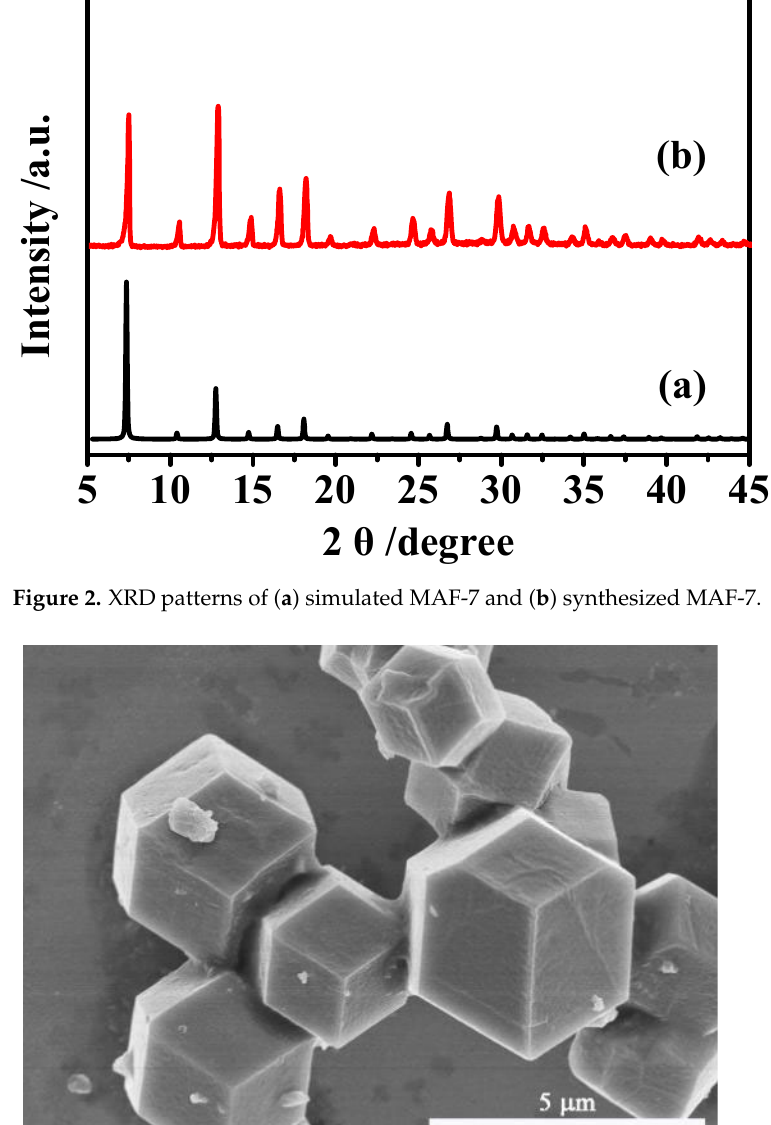
Figure 1. Schematic diagram of a constant volume/variable pressure set ‐ up for the gas permeation measurement.